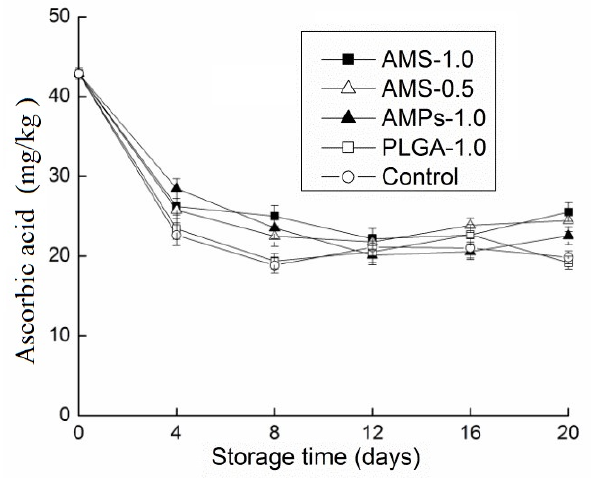
Figure 6. Effect of different antimicrobial coatings on ascorbic acid changes of Tricholoma matsutake stored at 4 ± 1 °C for 20 days. Each data point is the mean of three replicate samples.